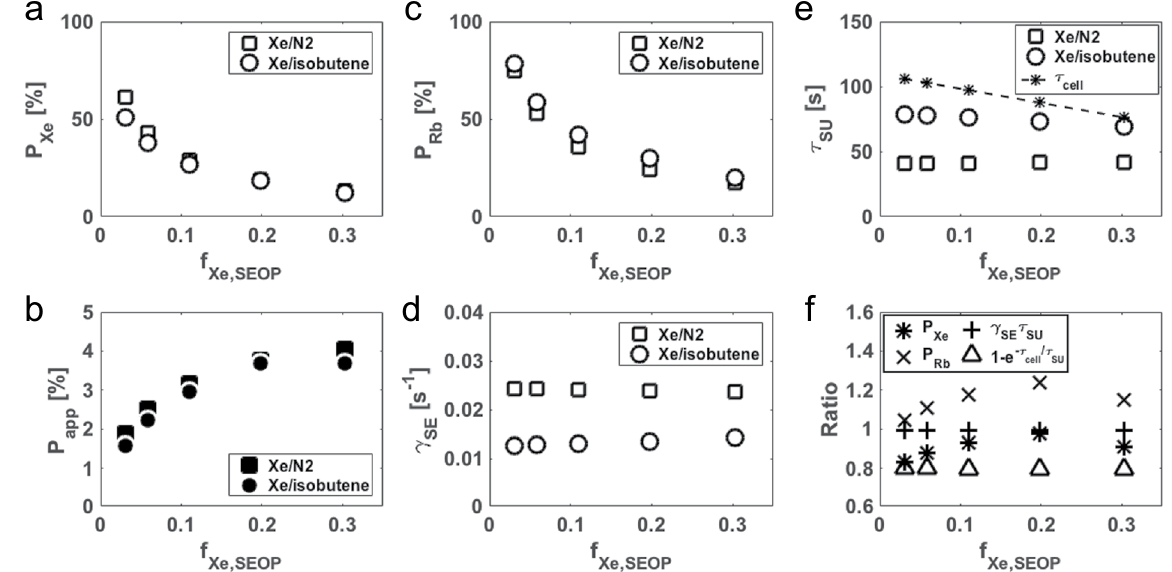
Figure 2. Comparison between isobutene and N 2 as the quenching gas for Rb-Xe SEOP. Plot of P Xe ( a ), P app ( b ), P Rb ( c ), γ SE ( d ), and τ SU ( e ) as a function of f Xe,SEOP for a Xe/N 2 mixture (rectangles) and Xe/isobutene mixture (circles) without the separation procedure. The residency time of atoms in SEOP cell, τ cell , is also shown in ( e ). ( f ) Plot of the ratio of P Xe , P Rb , γ SE τ SU , and a factor of − τ τ − e 1 / cell SU for isobutene mixture relative to those for N